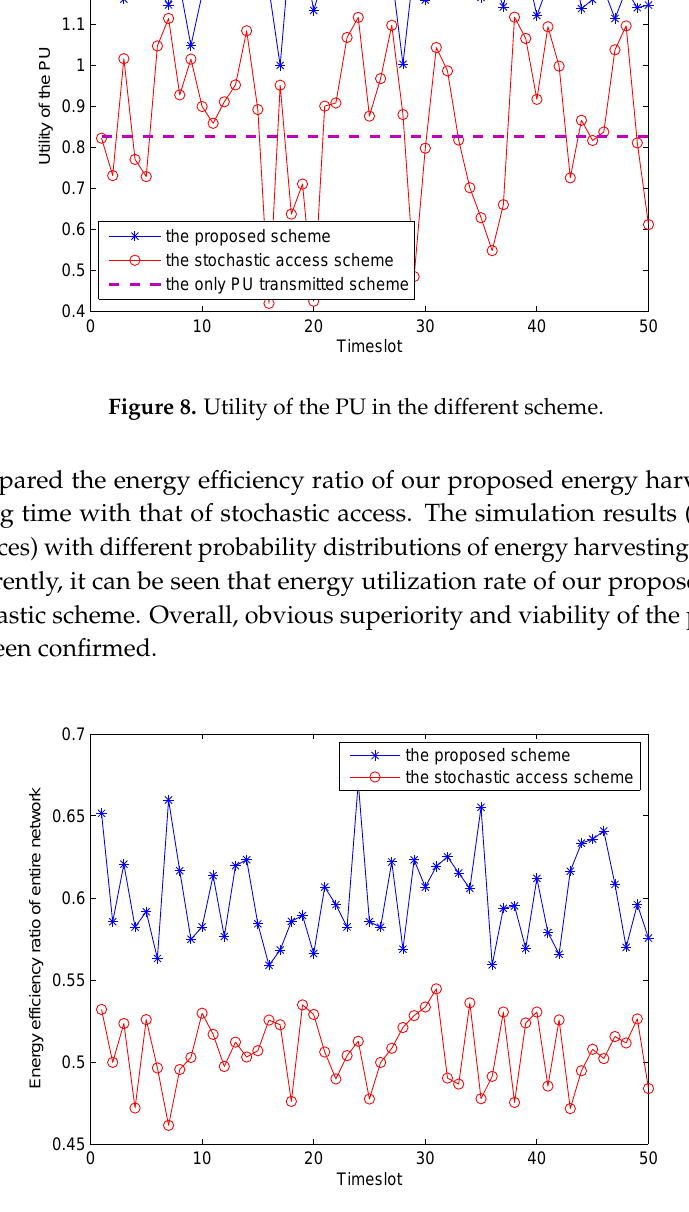
Figure 9. The energy efficiency ratio η in the different